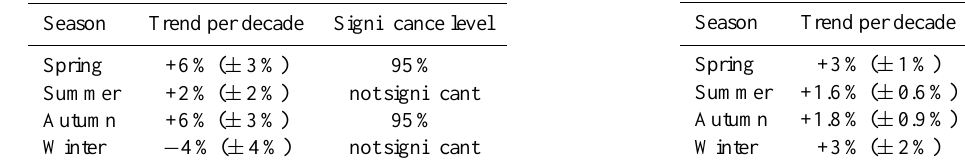
Figure 2. Trends of monthly anomalies at Uccle for erythemal UV dose (upper left panel), global solar radiation (upper right panel), total ozone column (lower left panel) and aerosol optical depth at 320.1nm (lower right panel) for the time period 1991–2013. The blue lines represent the time series, whereas the red lines represent the trend over the time period. Table 3. Seasonal trends of global solar radiation (1991–2013). Table 4. Seasonal trends of total ozone column (1991–2013).